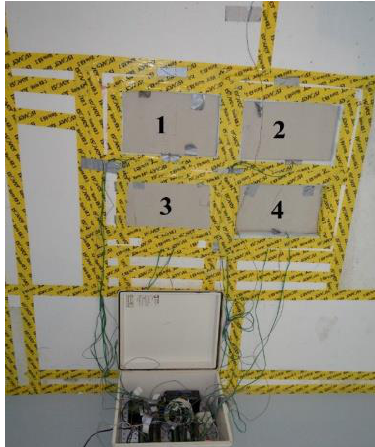
Fig. 2. Laboratory test stand with four historic masonry patterns and four insulation materials: 1 – wood fiber, 2 – mineral wool, 3 – expanded polystirene board, 4 – granulated aerogel. Relative humidity and temperature were measured between insulation and masonry (on the middle of the brick), and in both chambers with 8 temperature sensors and 5 relative humidity sensors. Time step of both measurements is 1